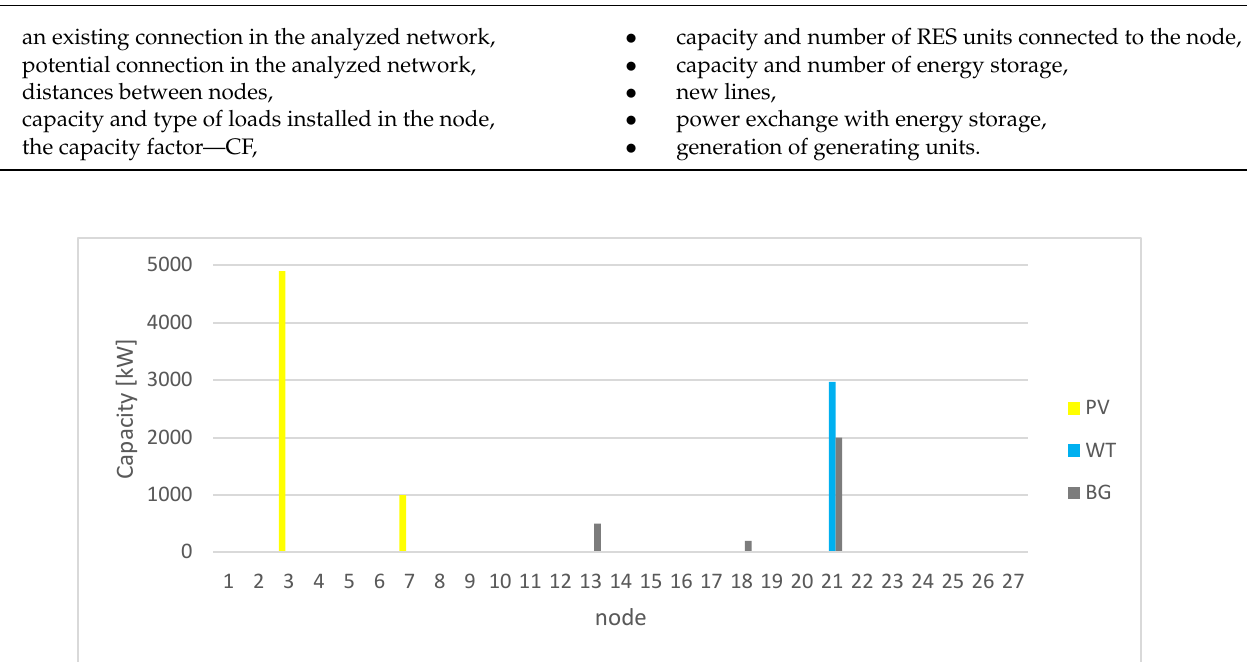
Figure A2. Capacity structure for scenario “1”.